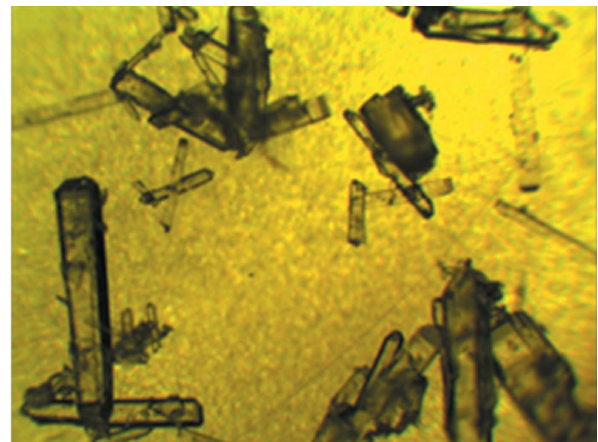
Figure 7 Crystals of the title compound 4